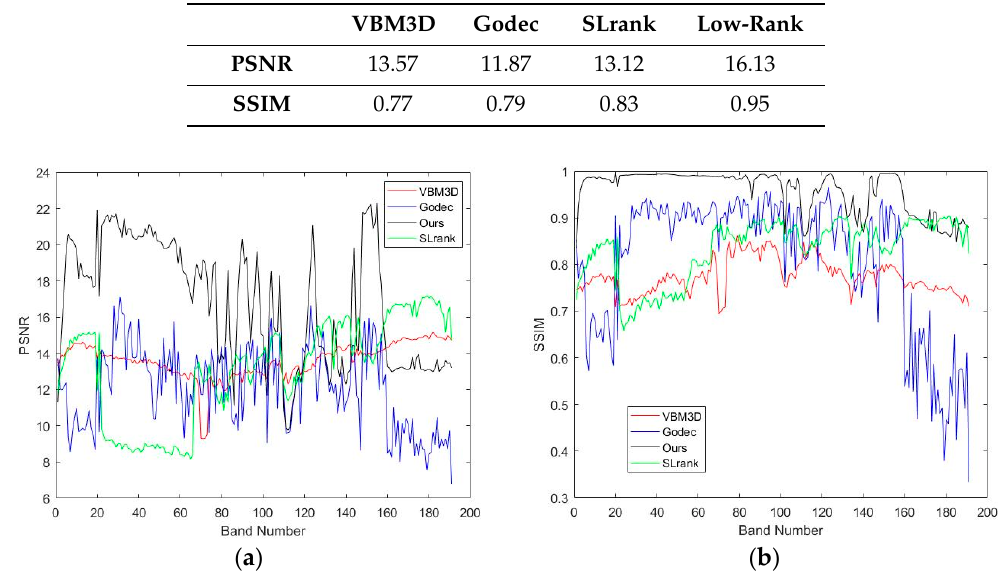
Figure 7. PSNR and SSIM values varied with different bands for different restoration methods.